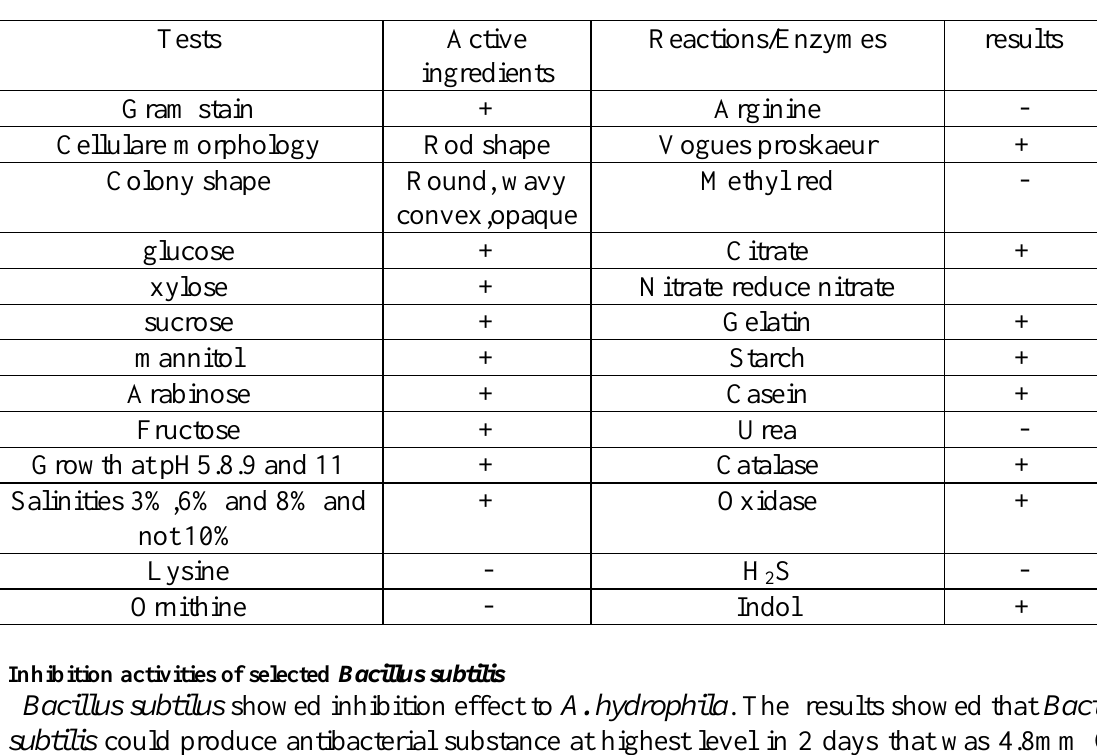
Table (1) Identification of isolated Bacillus subtilis using morphological and biochemical characterization